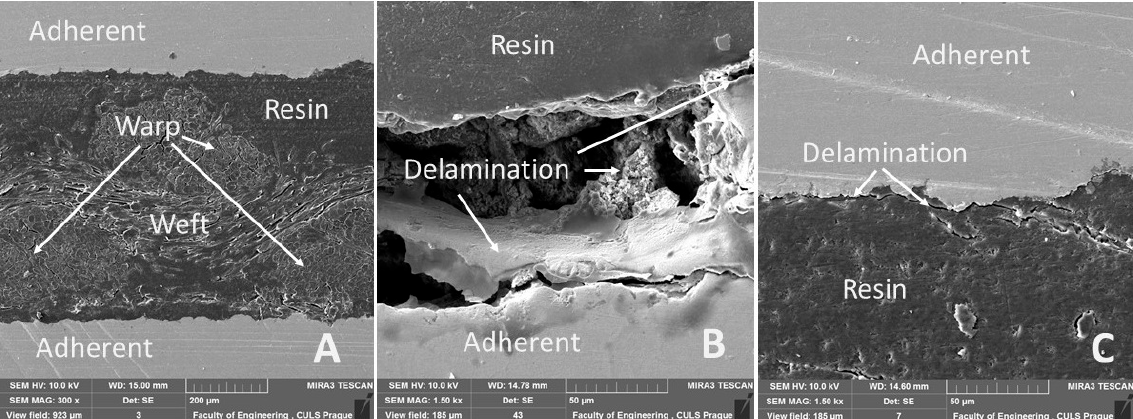
Figure 12. SEM images of cross-section through adhesive bonds: ( A ): cut through Tera-Flat reinforced bond, 1000 cycles in interval 5–70% (267–3743 N) (MAG 300×); ( B ): cross-section of Erik-WH1, 1000 cycles in interval 5–50% (267–2674 N) (MAG 1500×); ( C ): cross-section of Tera-Flat, 1000 cycles in interval 5–70% (267–3743 N) (MAG 1500×).